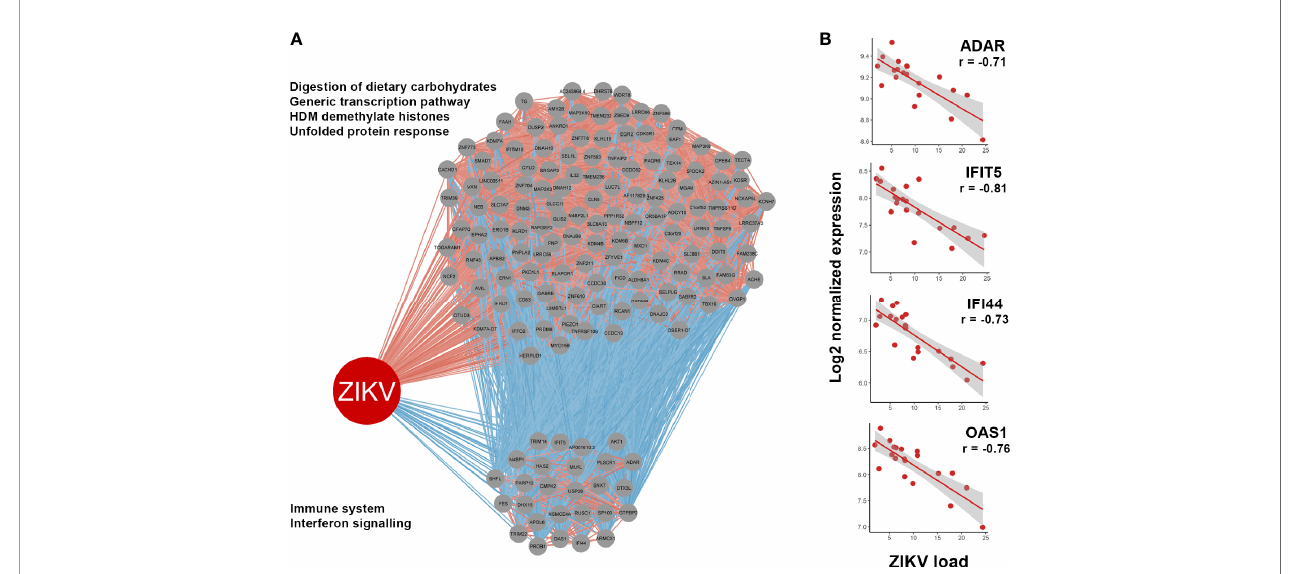
FIGURE 5 | (A) Correlations between genes upregulated in ZIKV-infected human iris pigment epithelial cells and read counts per million assigned to the ZIKV genome (ZIKV load). Spearman correlation, p < 0.05. Gray circles indicate upregulated genes. Red lines indicate positive correlations, and blue lines indicate negative correlations. Enriched Reactome pathways achieving false discovery rate < 0.05 are listed left of the relevant grouping, with annotations by InnateDB (35). (B) Examples of negative correlations between interferon (IFN)-stimulated genes and ZIKV load. Red dots indicate 20 individual donors. Line indicates trend. ADAR, adenosine deaminase, RNA-speci fi c; IFI44, IFN-induced protein 44; IFIT5, IFN-induced protein with tetratricopeptide repeats 5; OAS1, 2 ’ -5 ’ -oligoadenylate synthetase